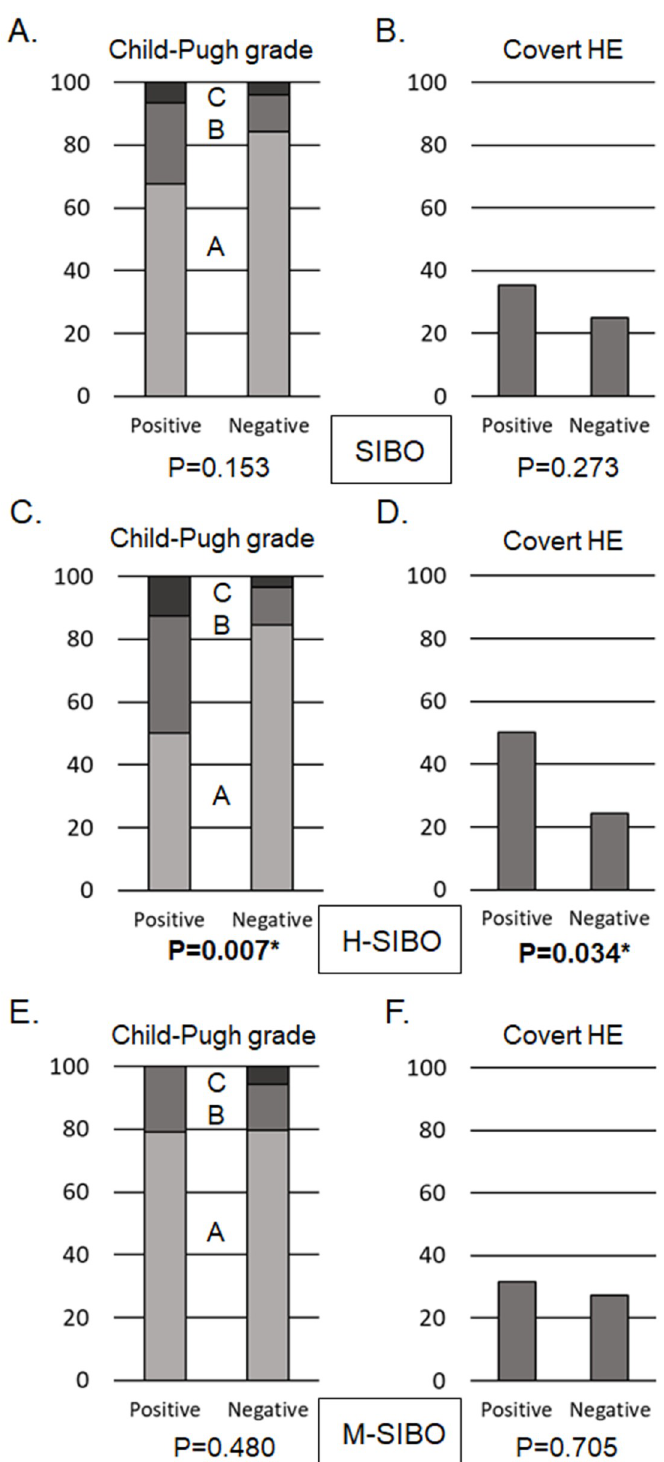
Fig 2. Relationship between the child-pugh scores of covert HE and the type of small intestinal bacterial overgrowth (SIBO). Overall, SIBO was not significantly associated with the Child-Pugh grade (grade A of 67.7%, grade B of 25.8%, and grade C of 6.5% in SIBO positive and grade A of 84.2%, grade B of 11.8%, and grade C of 3.9% in SIBO negative, P = 0.153; A) or covert hepatic encephalopathy (HE) (35.5% vs. 25.0%, P = 0.273; B). By contrast,